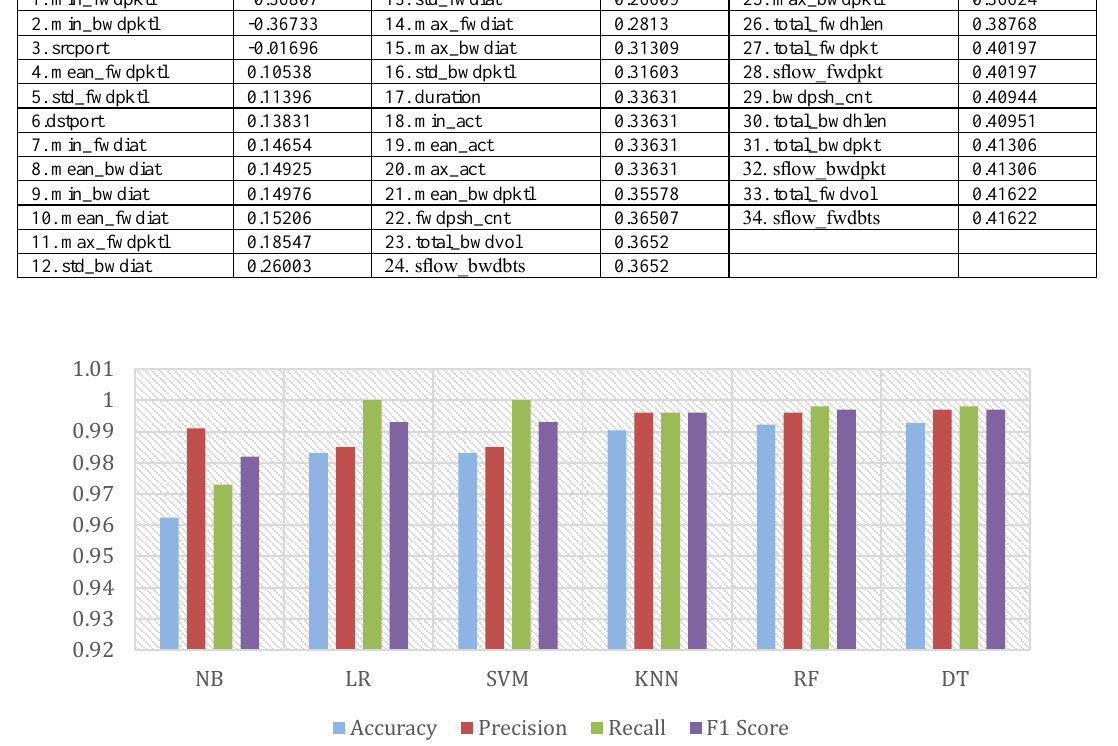
Figure 6. Accuracy, precision, recall and F1 score for selected